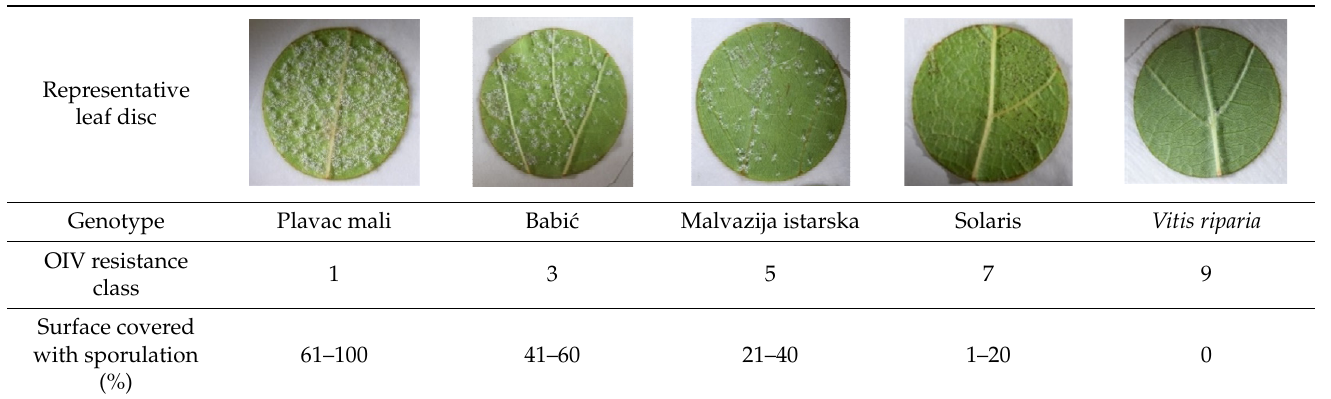
Table 2. Phenotypes of representative inoculated leaf discs at the time of the Plasmopara viticola sporulation evaluation.